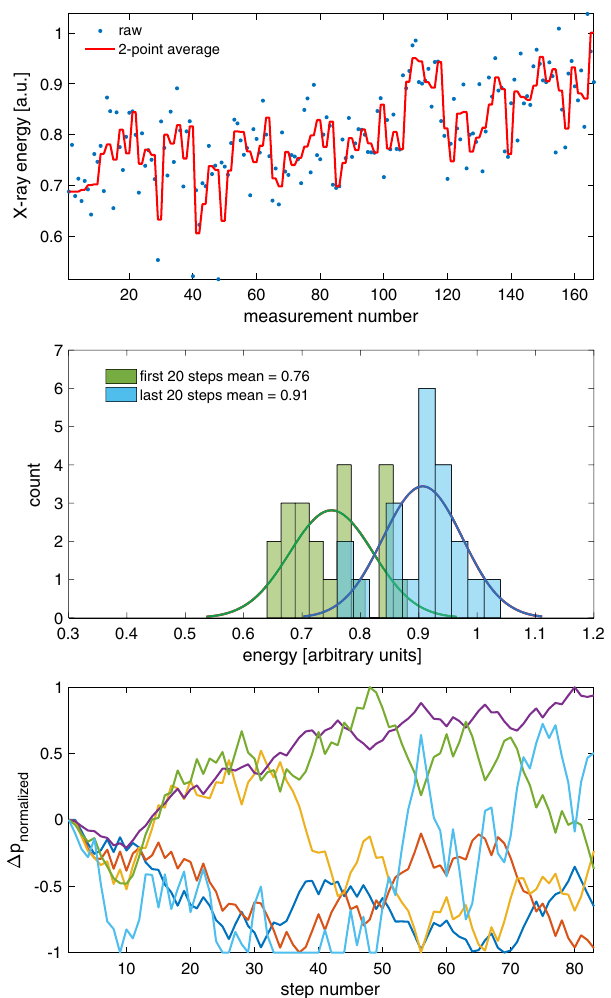
FIG. 12. The evolution of the output power (arbitrary units) and its 2-point moving average is shown alongside the normalized FEL parameter